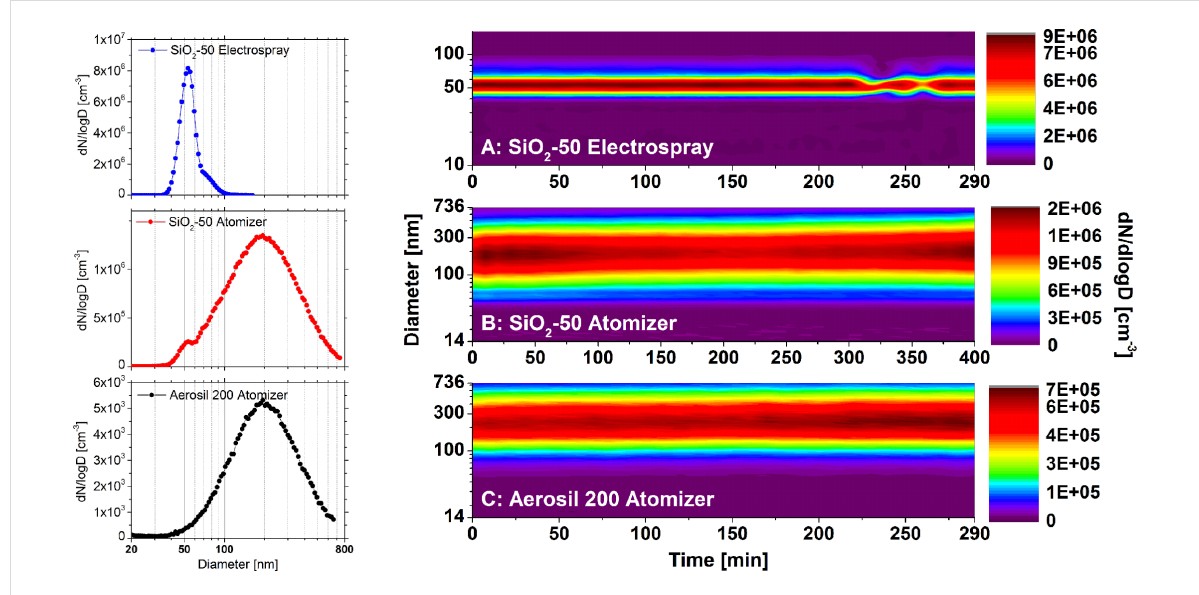
Figure 1: Temporal evolution of SiO 2 particle size distributions generated for cell exposure. (A) From an aqueous solution of SiO 2 -50 nm monomers (Stöber synthesis, Postnova) high number concentrations of airborne SiO 2 -50 nm monomers with a narrow size distribution were generated by elec- trospray. The atomizer, however, generated from the same nanoparticle suspension large agglomerates (B) allowing for the deposition of high mass doses. Large agglomerates with a broad size distribution were also generated by atomizing Aerosil200 (C). Initial size distributions are given on the left hand side of each time chart.